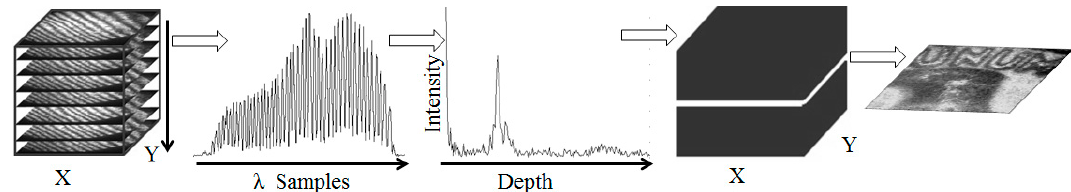
Figure 4. Signal processing steps (left to right) for acquiring the enface depth image. A stack of images is acquired by the camera along the wavelength axis, as indicated by the downward arrow. Next, a single interference signal is depicted with respect to the wavelength samples. A fast Fourier transform of this signal will provide the depth information. Hence, the respective enface depth image can be extracted from the 3D cube after processing all the acquired